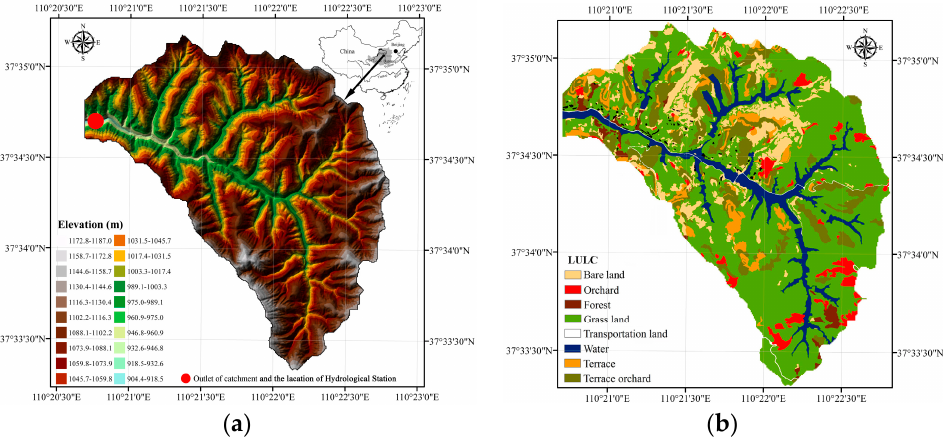
Figure 16. Wangmaogou catchment on the Loess Plateau, China. ( a ) Digital elevation model (DEM); ( b ) land use map (Landsat TM, 2012).